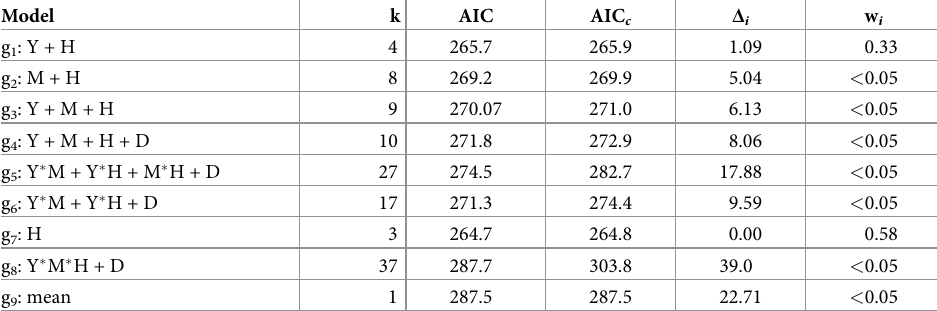
Table 2. Information theoretic analysis [71] of 9 logistic regression models (g i ) using base habitat (H), water depth (D), month (M), and year (Y) as predictors of Gracilaria vermiculophylla presence, where k is the number of parameters in a model, AIC is the Akaike information criterion, AIC between any model and the best model in the set, and w i is the model probability. Models g 8 and g 9 are the global model and null model,